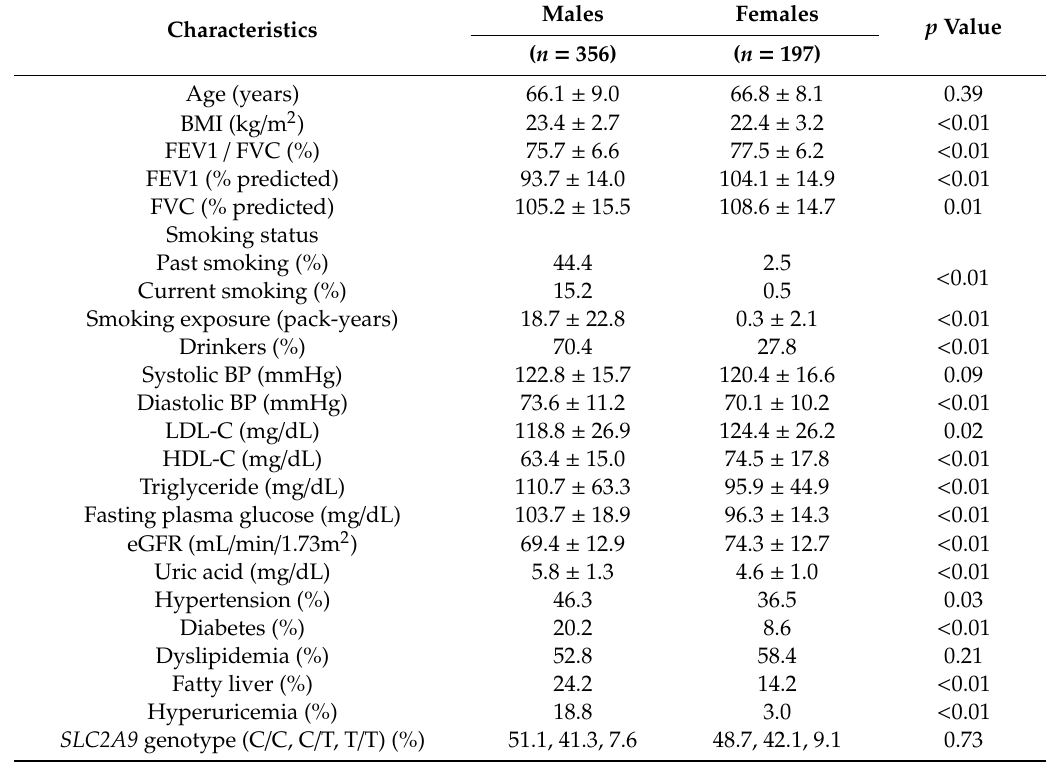
Table 1. The clinical characteristics of the study subjects.